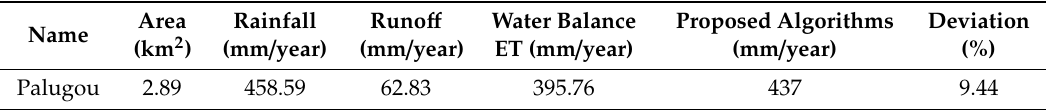
Table 5. Water balance measurements over the Palugou watershed (2012 to